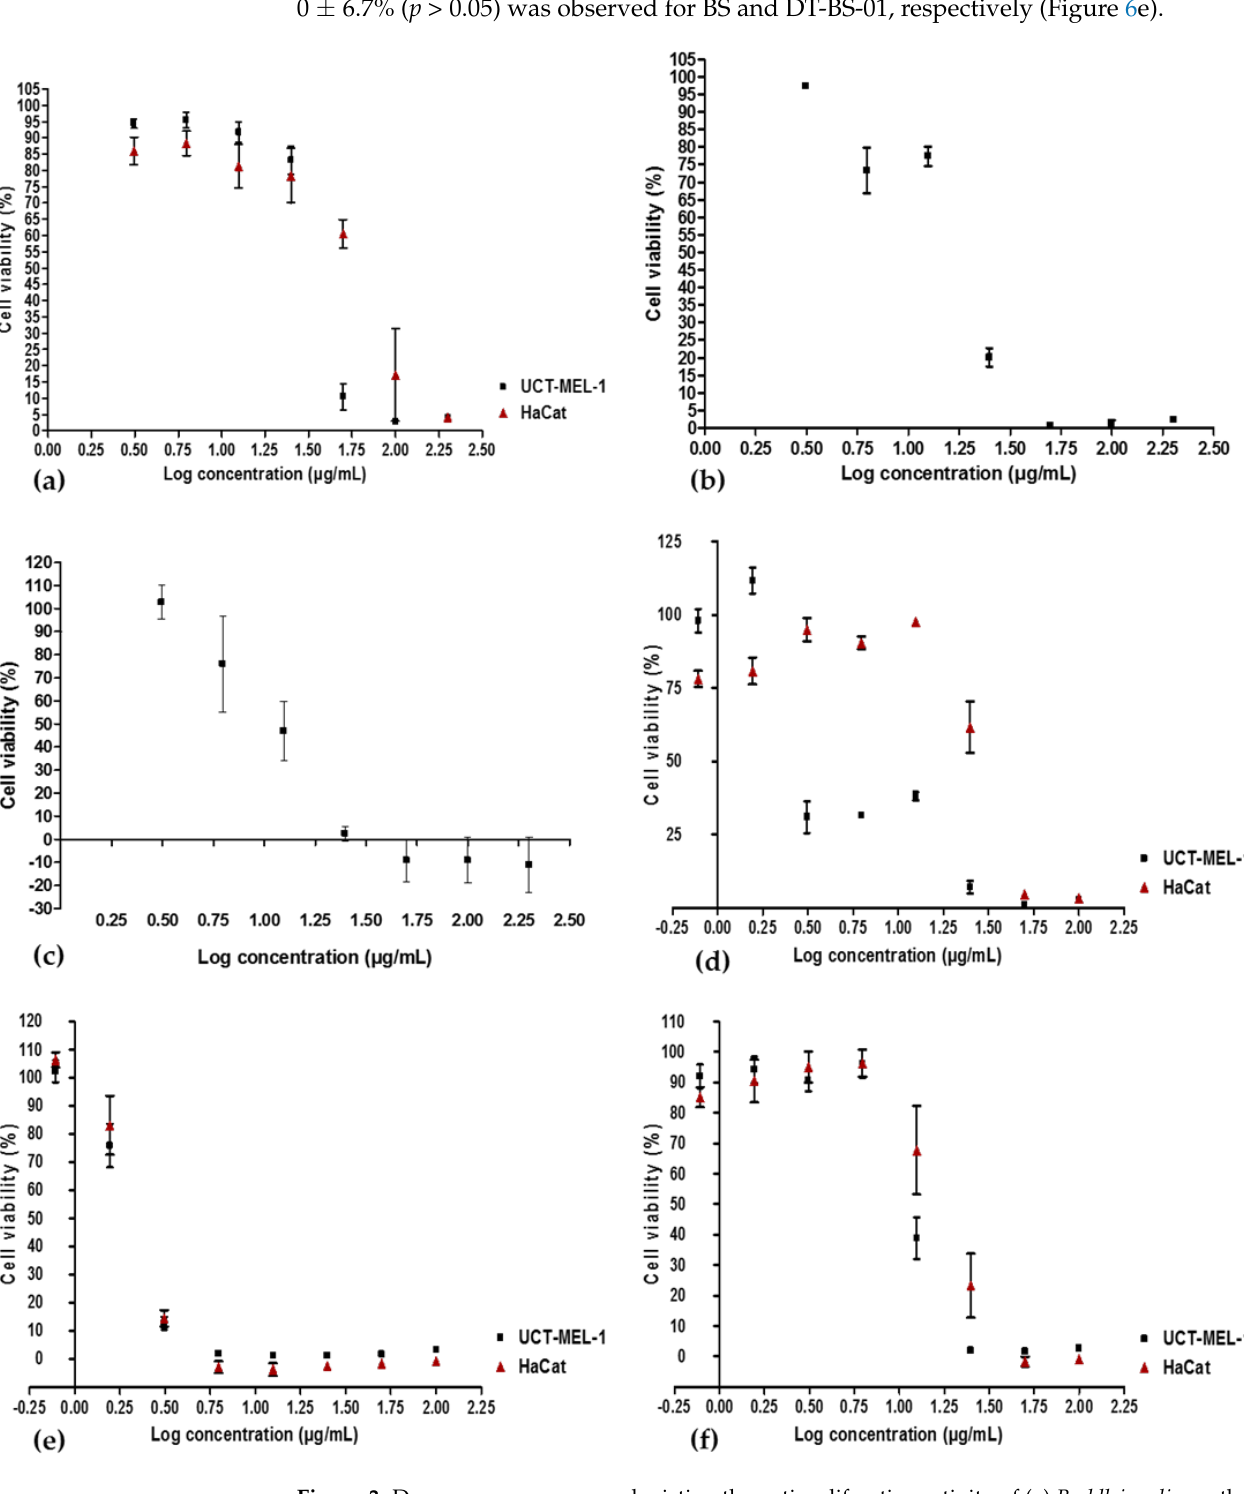
Figure 2. Fifty percent inhibitory concentration (IC 50 ) values of Buddleja saligna ethanolic extract, partitions, major fractions and compounds isolated from B. saligna for a 72 h treatment period